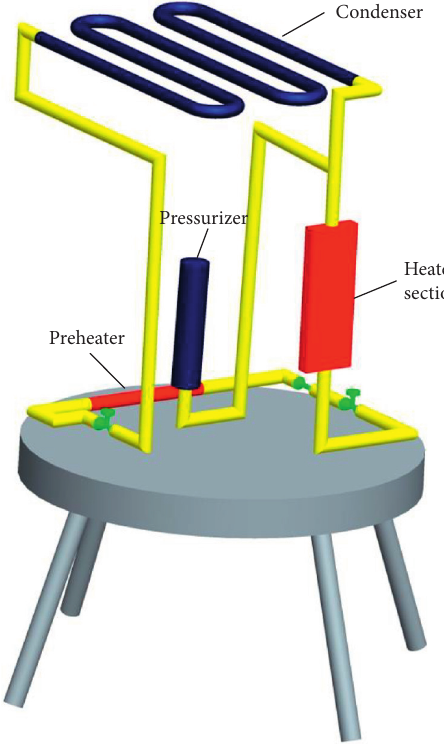
Figure 1: Natural circulation schematic